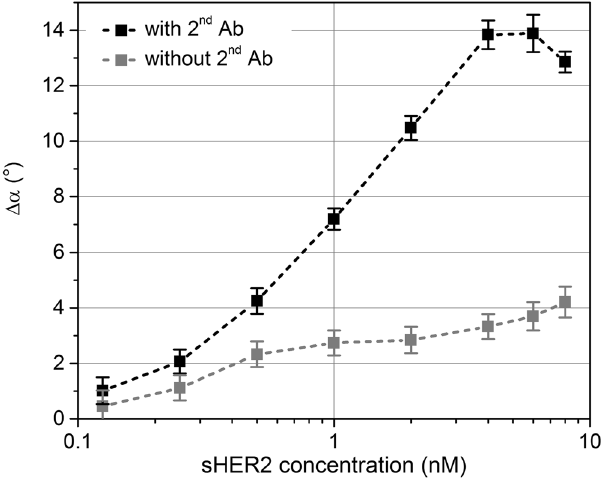
Figure 2. Phase lag difference signal Δα in pure buffer solution and its dependence on the antigen concentration. Measurement signal with (black curve) and without (grey curve) the addition of 2 nd